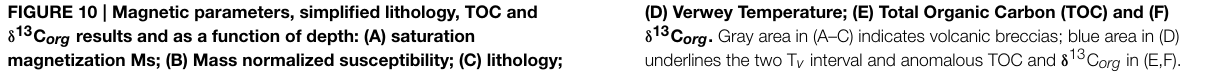
(D) Verwey Temperature; (E) Total Organic Carbon (TOC) and (F) δ 13 C org . Gray area in (A–C) indicates volcanic breccias; blue area in (D) underlines the two T v interval and anomalous TOC and δ 13 C org in